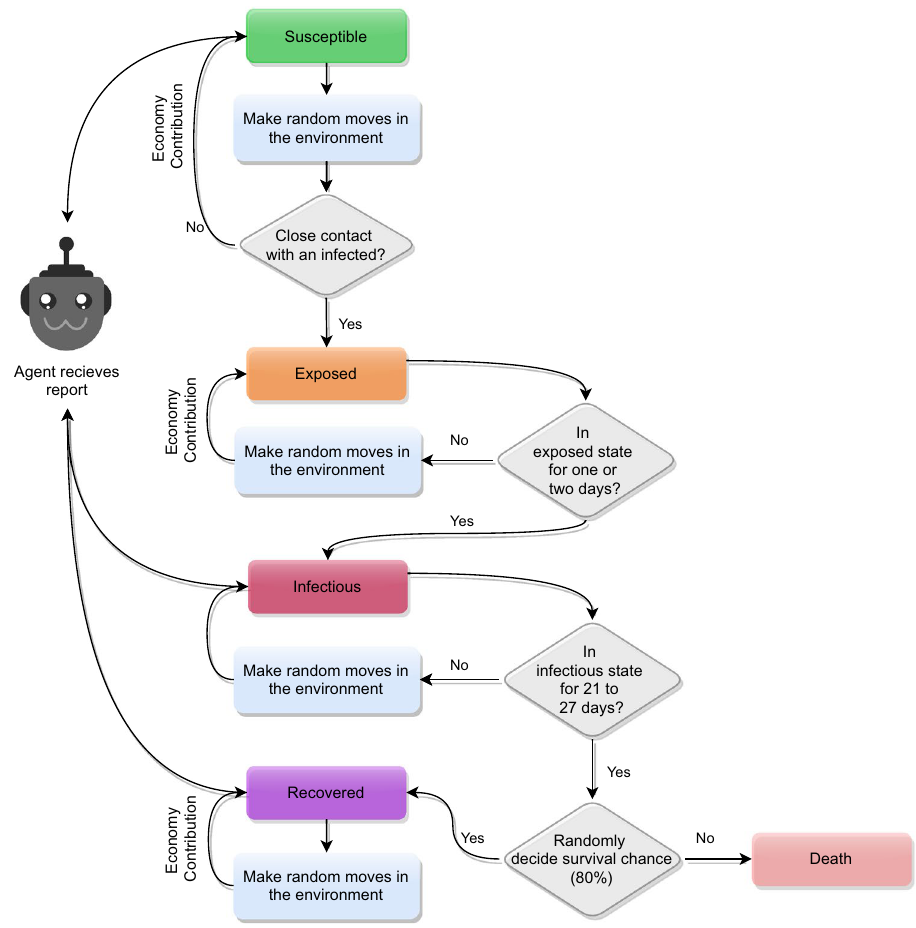
Figure 3. The figure illustrates the algorithmic steps of the environment. The agent receives a daily report of the susceptible, infectious, recovered, and dead population (not presented in the flowchart). Also, the infectious population does not contribute to the economy. The pseudocode of the algorithm is available as a Supplementary file